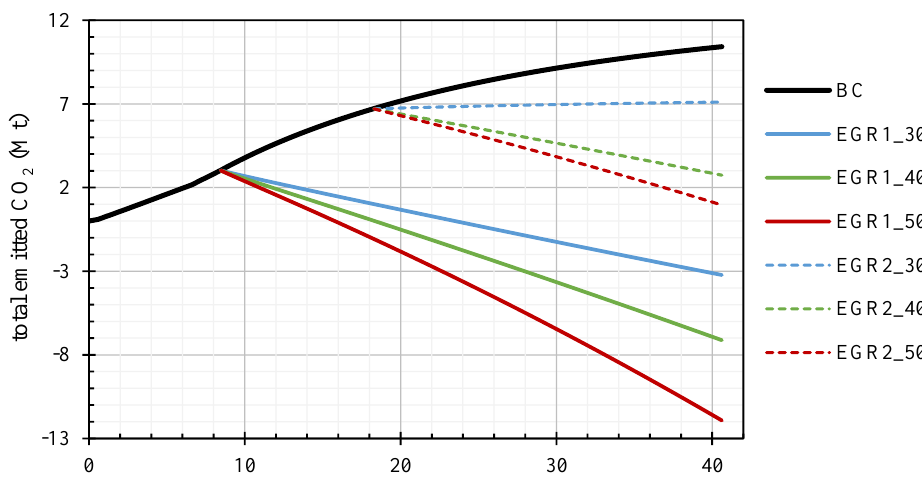
Figure 6. Total emitted CO 2 in each scenario.